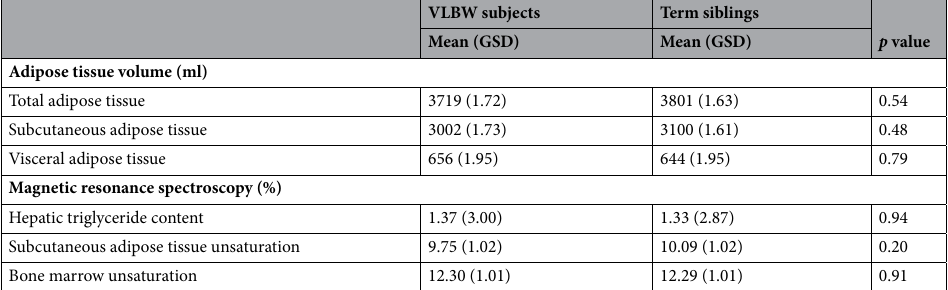
When comparing the volumetric outcome variables in unadjusted paired t-tests (70 whole pairs), the abdomi- nal adipose tissue results were similar between VLBW subjects and their siblings: total abdominal adipose tis-